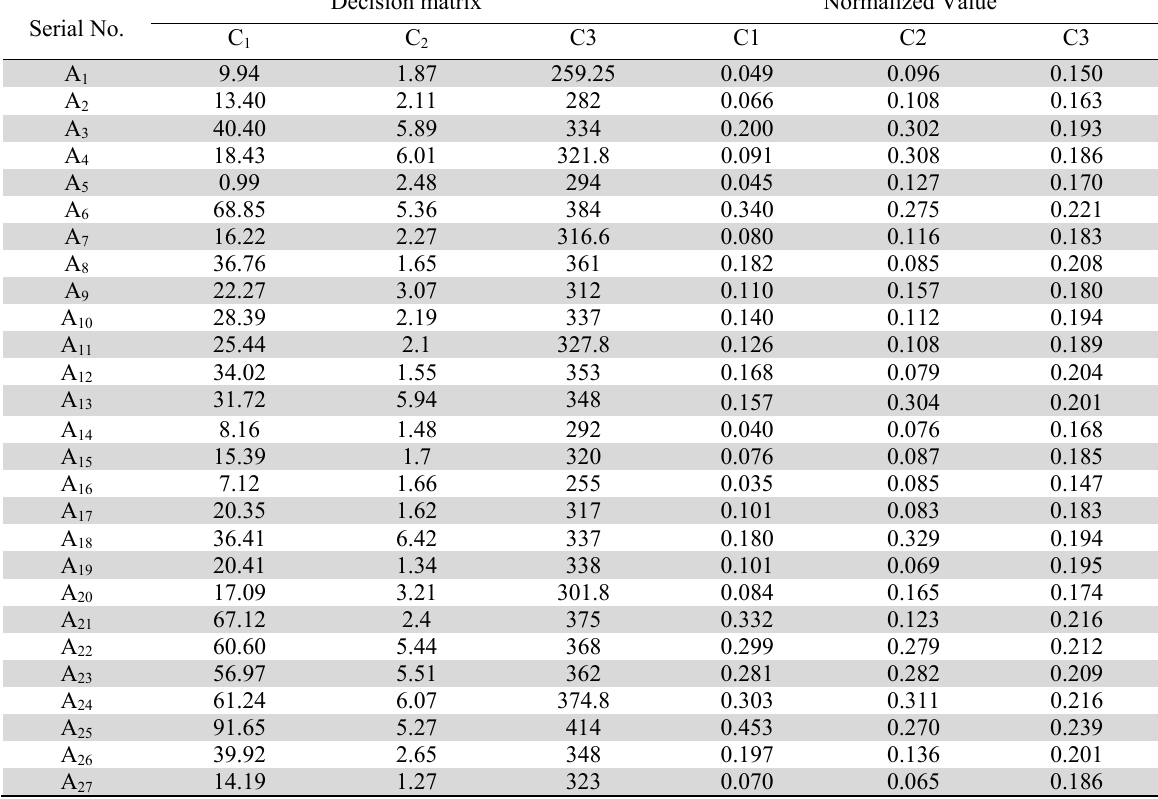
Decision matrix and Normalized data matrix for optimal cutting parameters selection problem Decision Serial No.